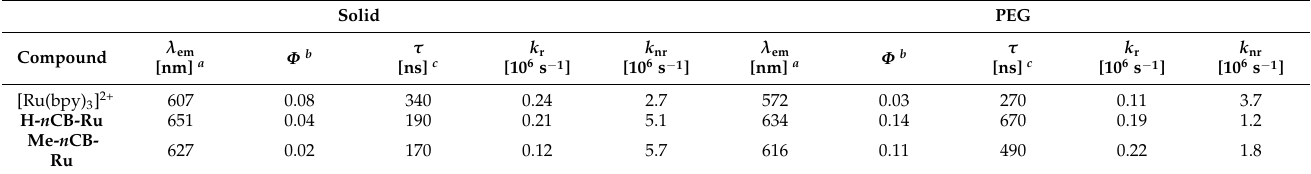
Table 2. Photophysical properties of the complexes in solid state and 1 wt% PEG